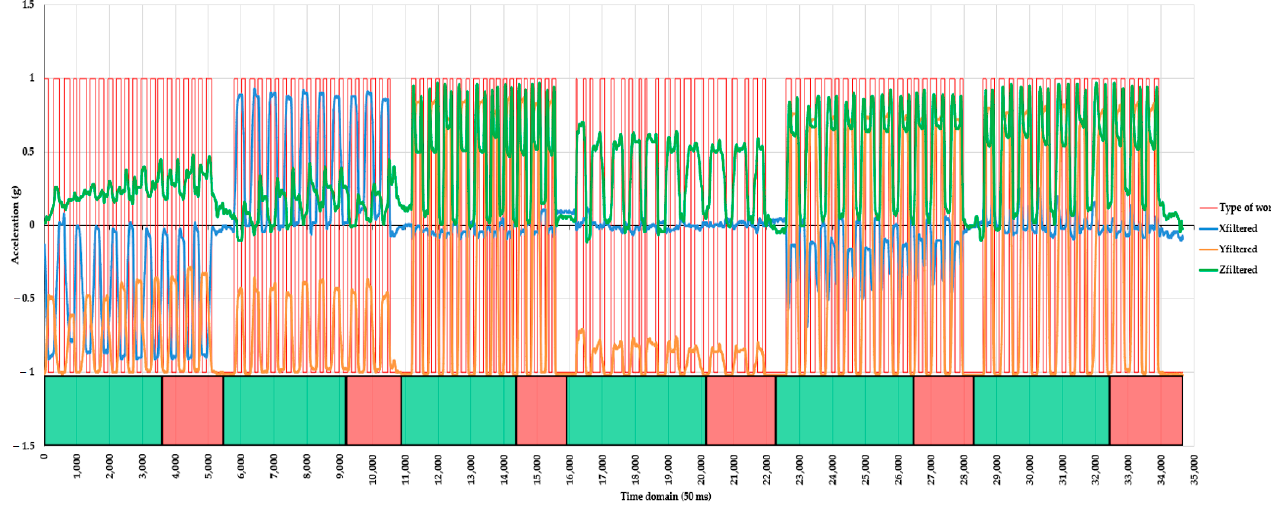
Figure 3. Data partitioning into training (green strips at the bottom of the figure) and testing (red strips at the bottom of the figure) data subsets. Legend: Xfiltered, Yfiltered, and Zfiltered are the values of the signals on the three axes after applying a median filter with a window size of 41; type of work is an arbitrary signal taking a value of 1 when dynamic work (movement) was present and − 1 when static work (no movement) was present.